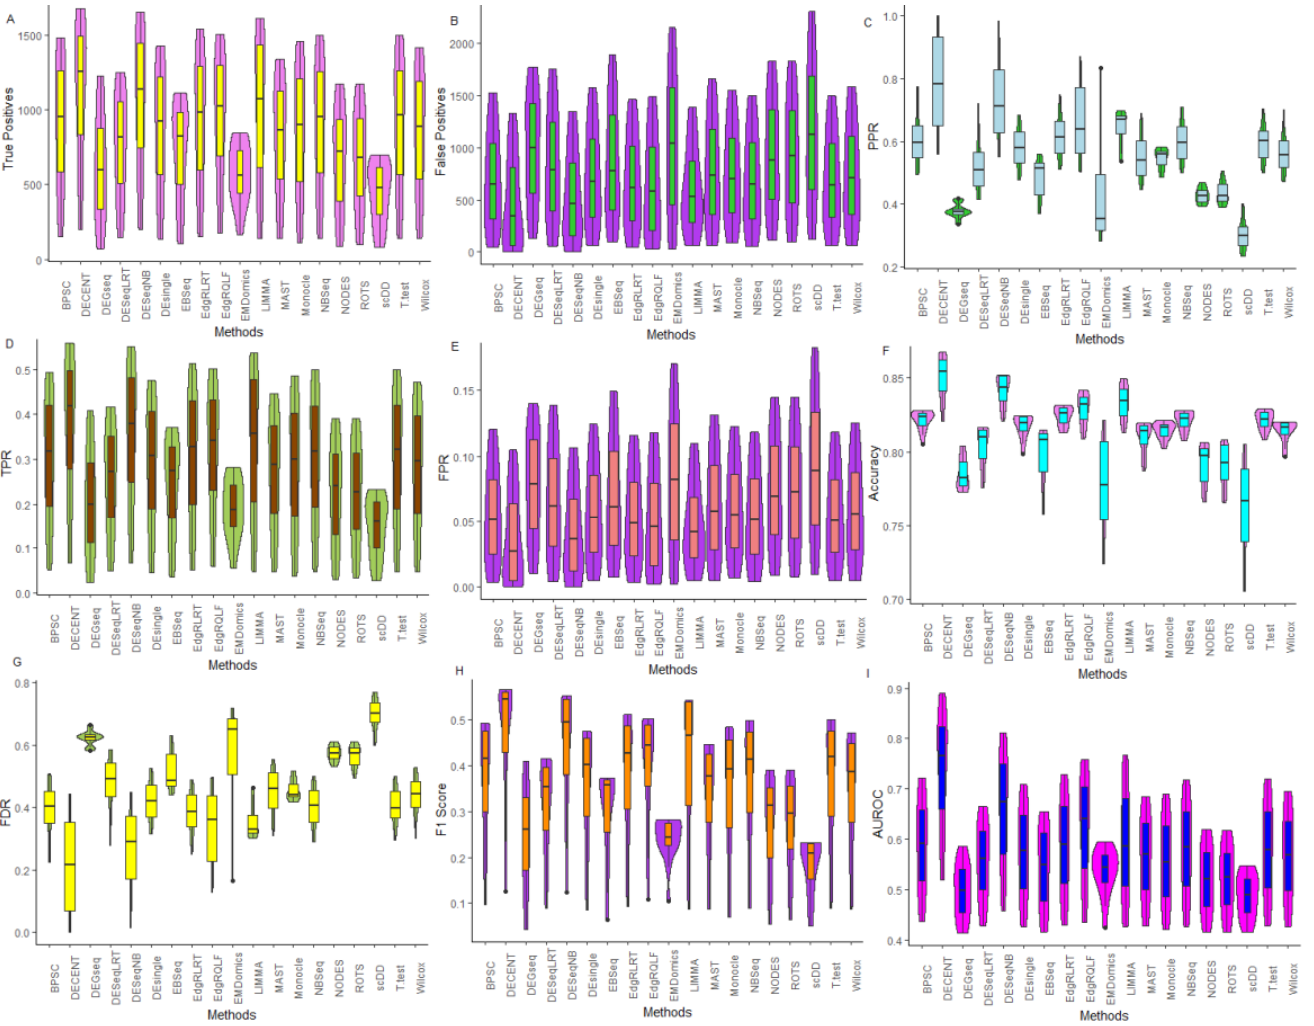
Figure 2. Comparative evaluation of DE methods through performance metrics for Soumillion2 data. The tested DE methods are evaluated on Soumillion2 data through the performance evaluation metrics, such as TP, FP, TPR, FPR, PPR, FDR, Accuracy, F1 ‐ score, and AUROC. The 19 tested methods are shown in X ‐ axis. The violin plots are shown for the compar ‐ ative evaluation of tested methods through ( A ) TP; ( B ) FP; ( C ) PPR; ( D ) TPR; ( E ) FPR; ( F ) Accuracy; ( G ) FDR; ( H ) F1 ‐ score; and ( I ) AUROC. The violin plot shows full distribution of performance metrics computed for each tested method. The box represents the inter ‐ quartile range; the horizontal line represents the median, and the bars on the boxes show 1.5x inter ‐ quartile range. Table 4. Evaluation of DE methods based on performance evaluation metrics for Soumillon2 scRNA ‐ seq data. TP FP